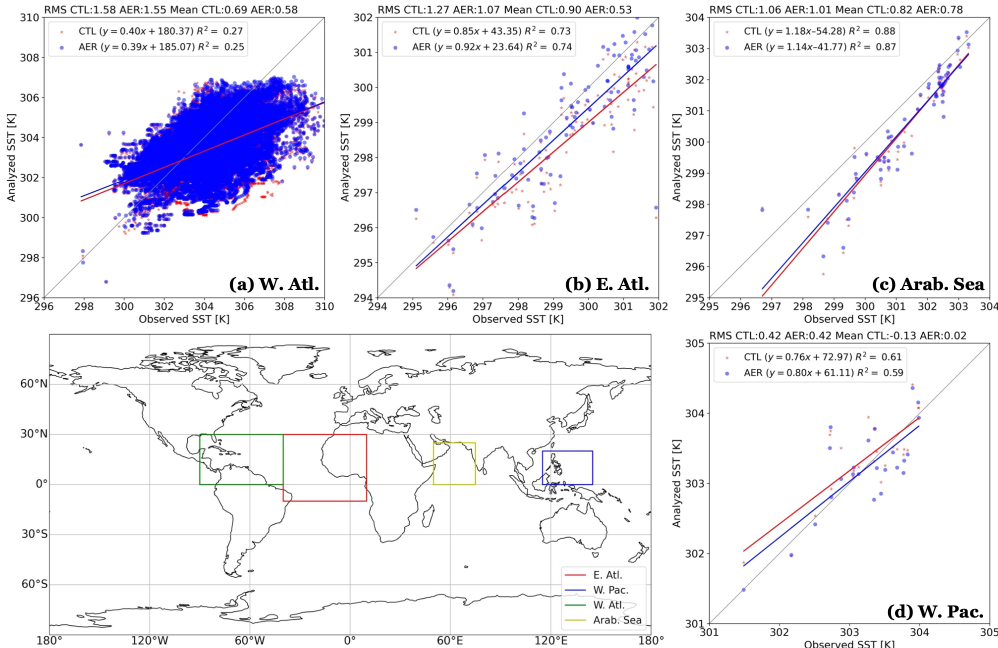
Figure 13. Scatter plots of the analyzed sea surface temperature against the ingested measurements over ( a ) West Atlantic, ( b ) East Atlantic ( c ) Arabian Sea, and ( d ) West Pacific. Corresponding areas are indicated in the lower left panel. Mean and RMS OMAs are indicated in the caption of each